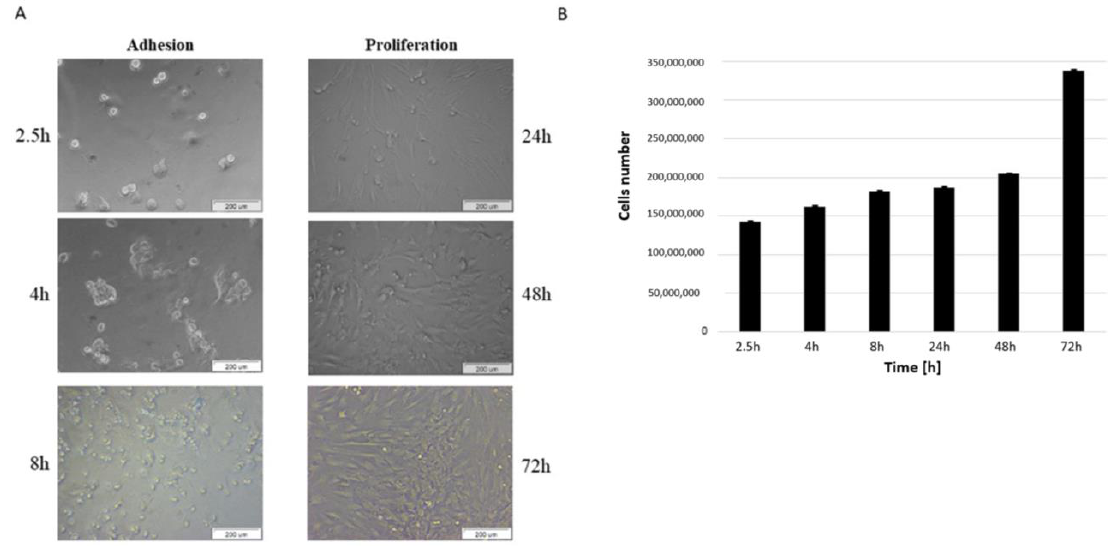
Figure 1. Adhesion and proliferation of bmMSC cells. ( A ) Bright-field images for bmMSCs after 2.5, 4, 8, 24, 48 and 72 h of culture. Scale bar: 200 μm. ( B ) Cells number after 2.5, 4, 8, 24, 48 and 72 h of culture were determined by automated counting. The bars represent the means ± SD ( n = 3).